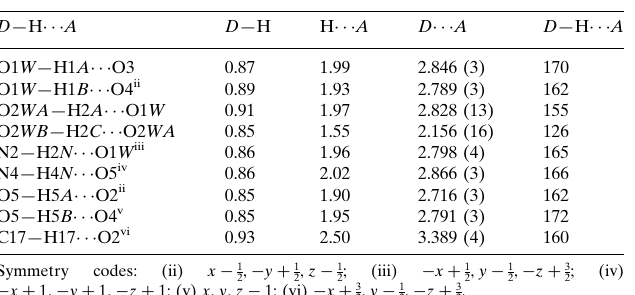
Hydrogen-bond geometry (A˚ , (cid:2)